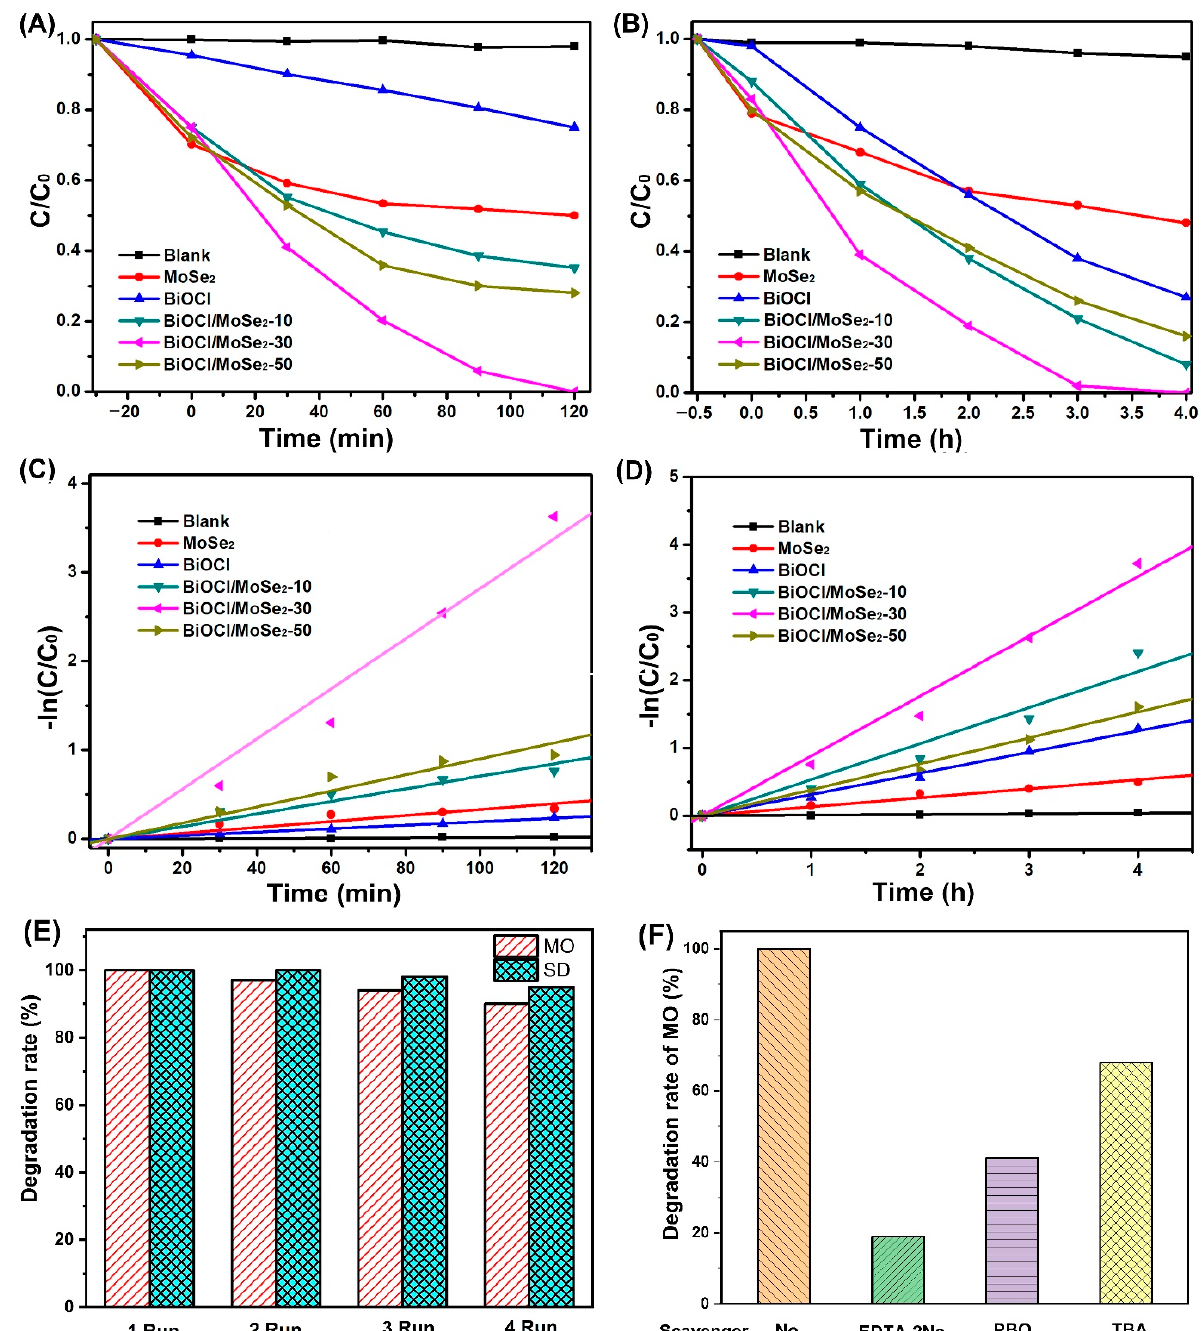
(vs. NHE). According to the equation of E VB = E CB + E g (E VB is the potential of VB), the potential of MoSe 2 VB was further calculated to be 1.31 eV.